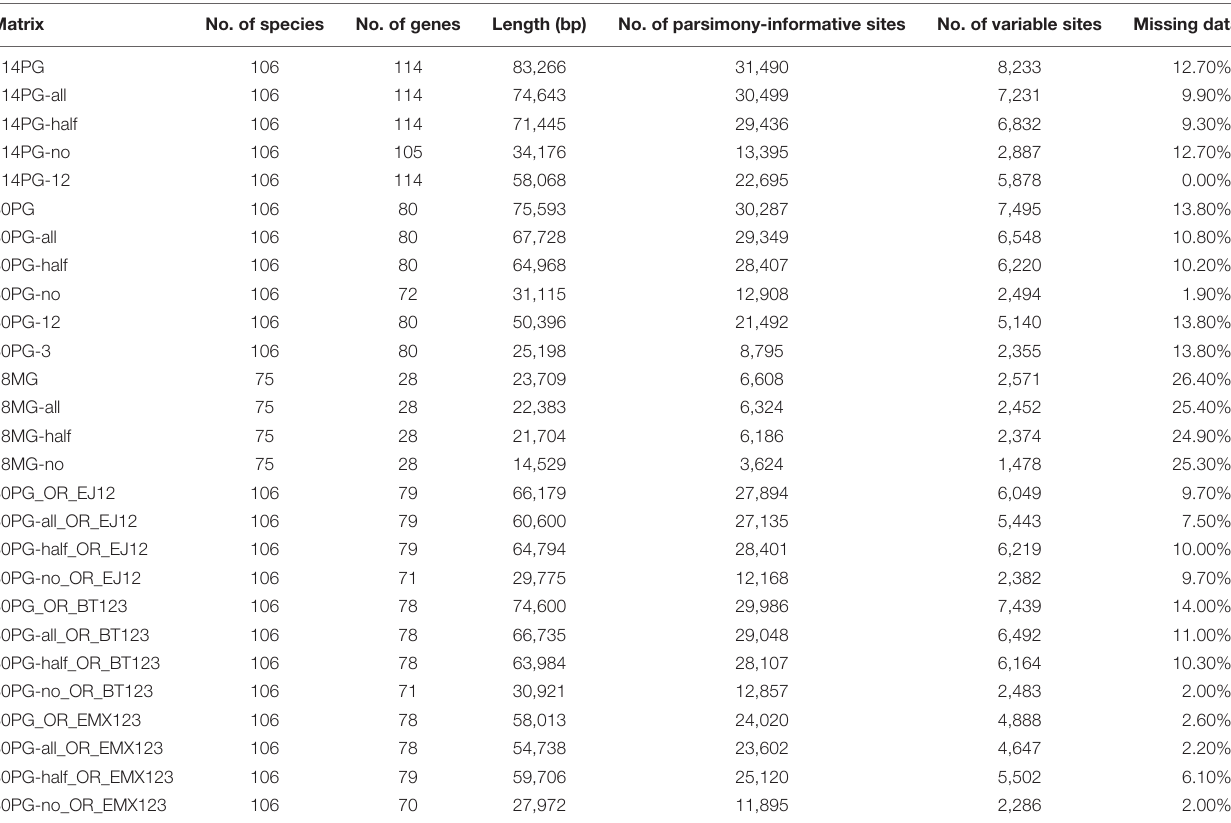
TABLE 1 | Characteristics of plastid and mitochondrial matrices used for phylogenetic analyses of